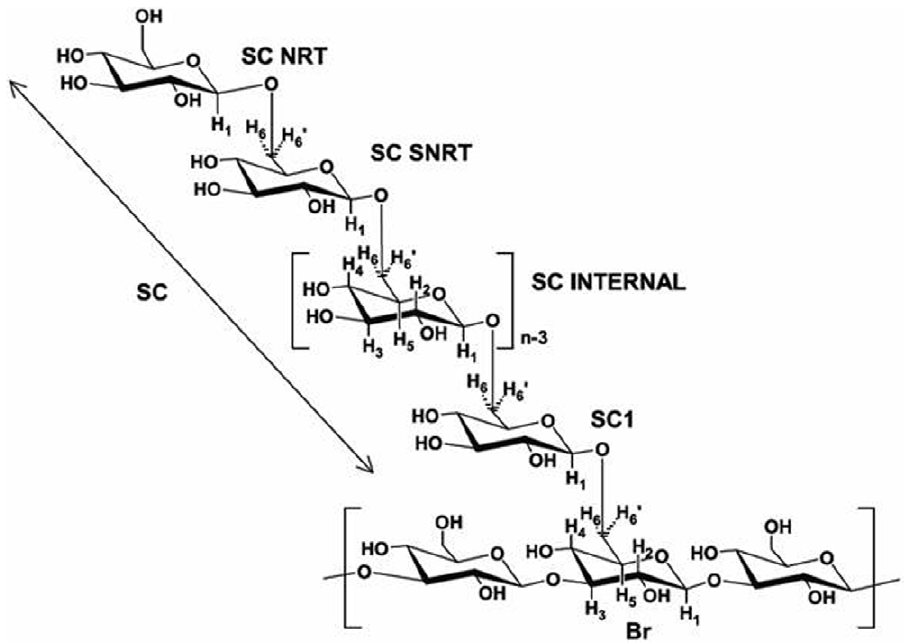
Figure 6. Schematic structure of the poly-(1 R 6)- b -D-glucan side chain containing n repeat units and attached to a segment of (1 R 3)- b -linked backbone chain.